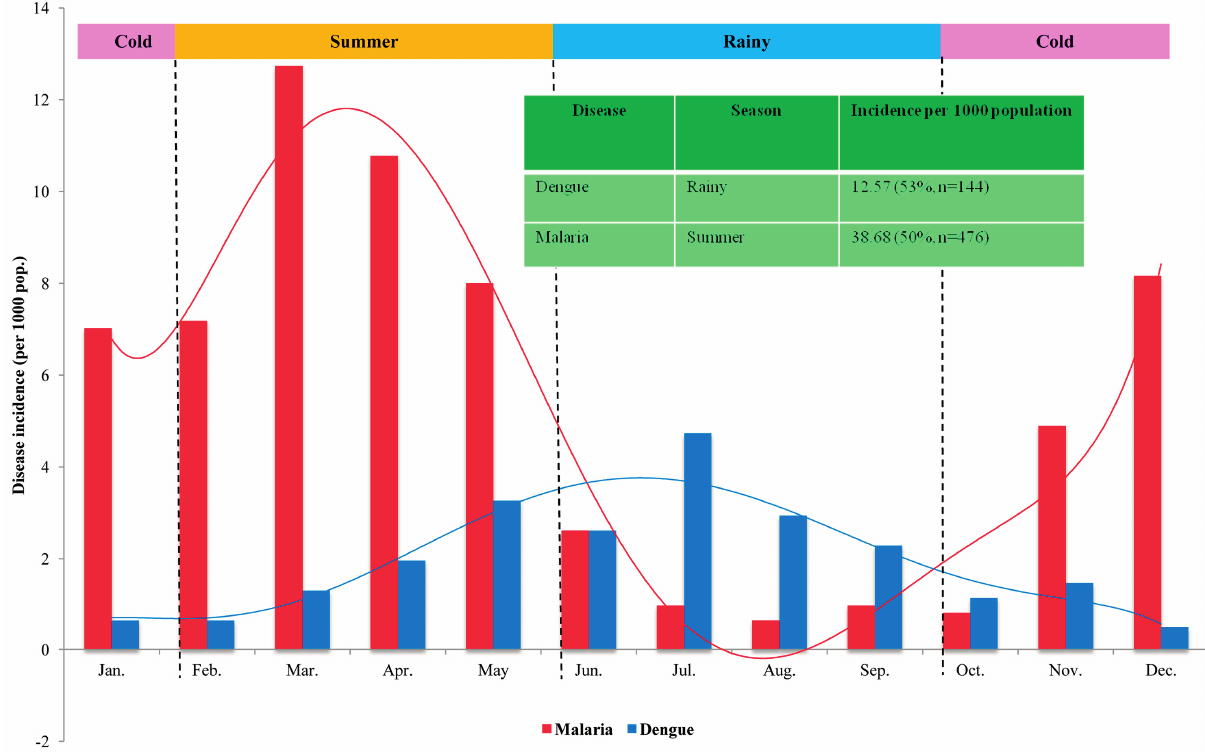
Figure 1. Number of dengue and malaria cases reported on monthly basis on Koh Chang during the years